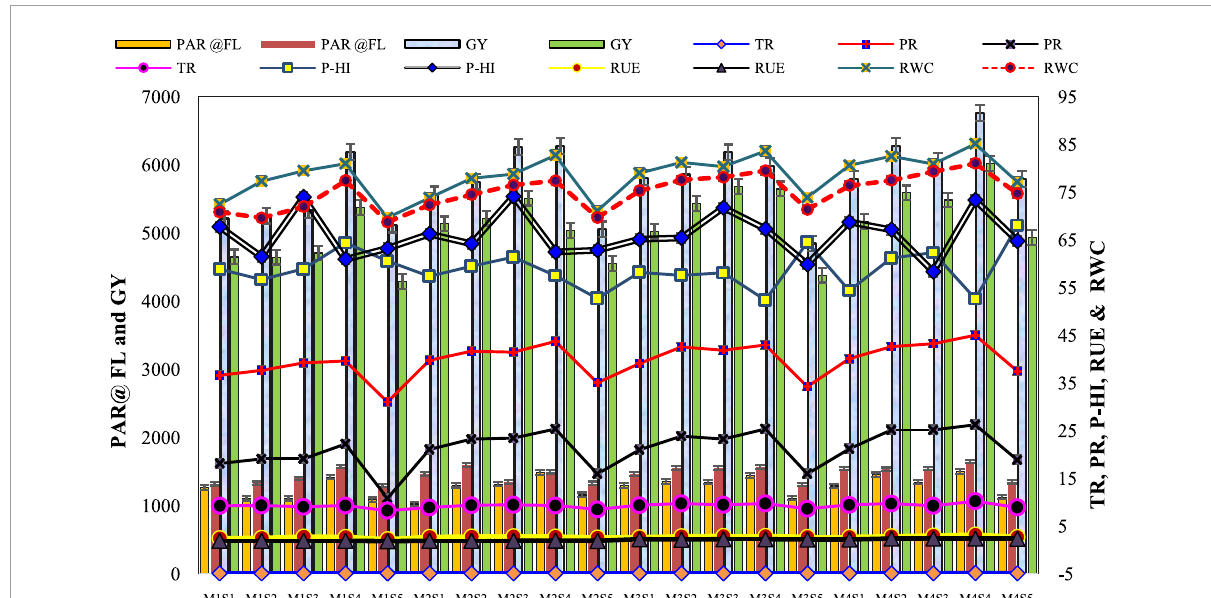
FIGURE4 Effect of crop establishment and tillage management (CETM) and P-fertilization practices on photosynthetic indices of maize and wheat under MWCS (2-years’ av.). The vertical bars represent the standard error of mean (SEM ± at p ≤ 0.05) . M 1 , flat bed–conventional tillage (FBCT) both in maize and wheat; M 2 , raised bed–CT (RBCT) in maize and RB–zero tillage (RBZT) in wheat; M 3 , FBZT both in maize and wheat; M 4 , permanent raised bed–ZT (PRBZT) both in maize and wheat. S 1 -P 100 , 100% P as basal; S 2 -P 50 + 2FSP, 50% P as basal (P 50 ) + 2 foliar sprays of phosphorus (2FSP) as DAP (2%) at knee-high stage (KHS) and pre-tasseling stage (PTS) in maize and at tillering stage (TS) and pre-flowering stage (PFS) in wheat; S 3 -P 50 + PSB + AMF, P 50 + PSB + AM-fungi (AMF); S 4 -P 50 + PSB + AMF + 2 FSP, P 50 + PSB + AMF + 2FSP at KHS and PTS in maize and at TS and PFS in wheat; S 5 -P 0 , 100% N and K with no P (P 0 ) as